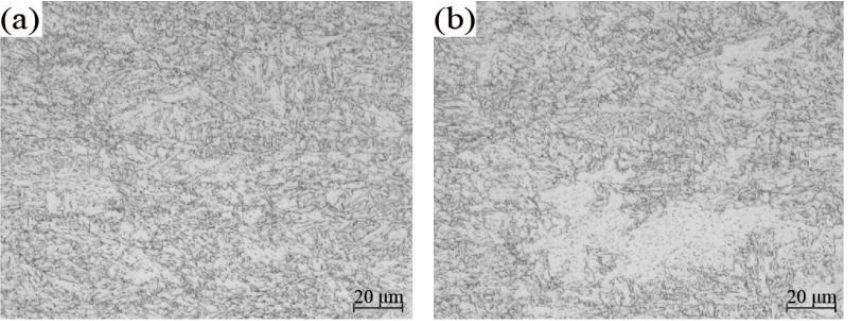
Figure 8. Microstructure of the samples at different coiling temperatures in industry: ( a ) 403 °C and ( b ) 467 °C.